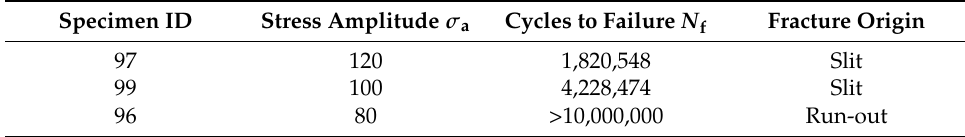
Table A3. Fatigue test results for WS1.5.